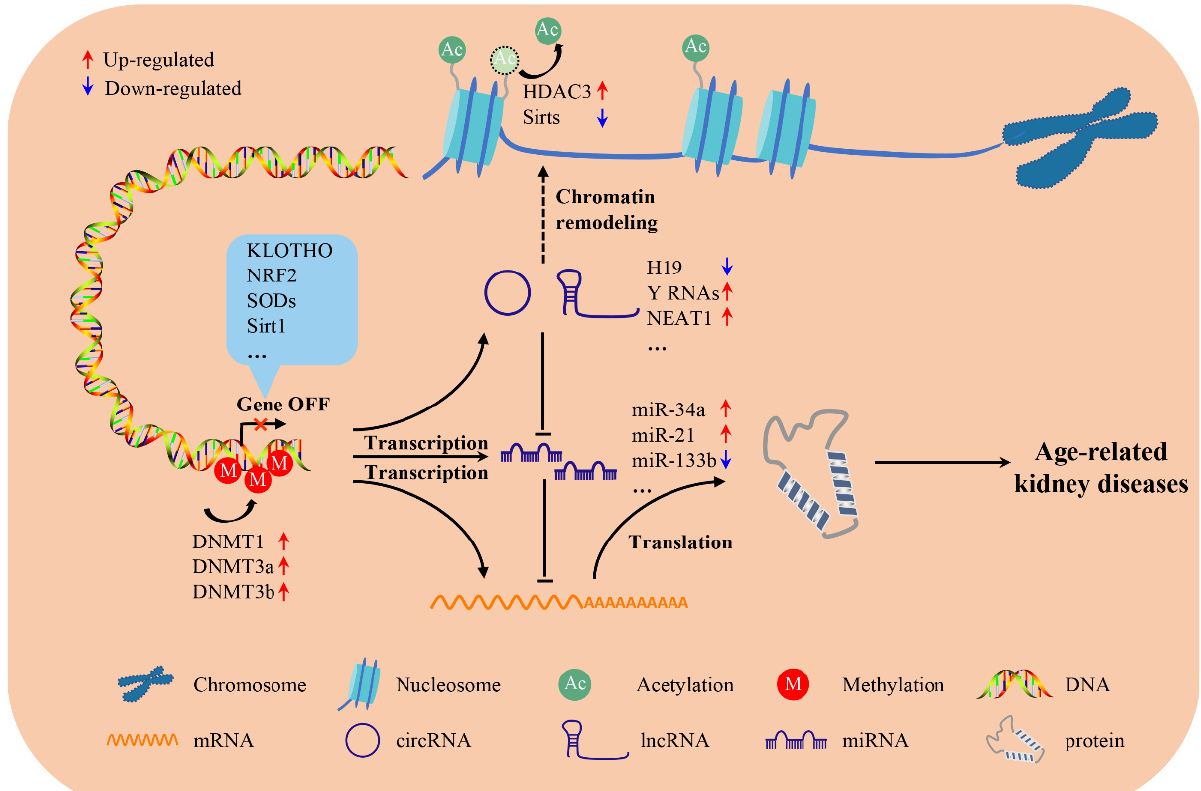
Figure 3. Schematic diagram of the mechanisms of the main epigenetic alterations in age-related kidney diseases. Aberrant DNA methylation, abnormal histone modifications as well as regulation by ncRNAs are associated with age-related kidney diseases. These changes have been implicated in age-related kidney diseases through the alteration of certain genes expression in various kidney cells.